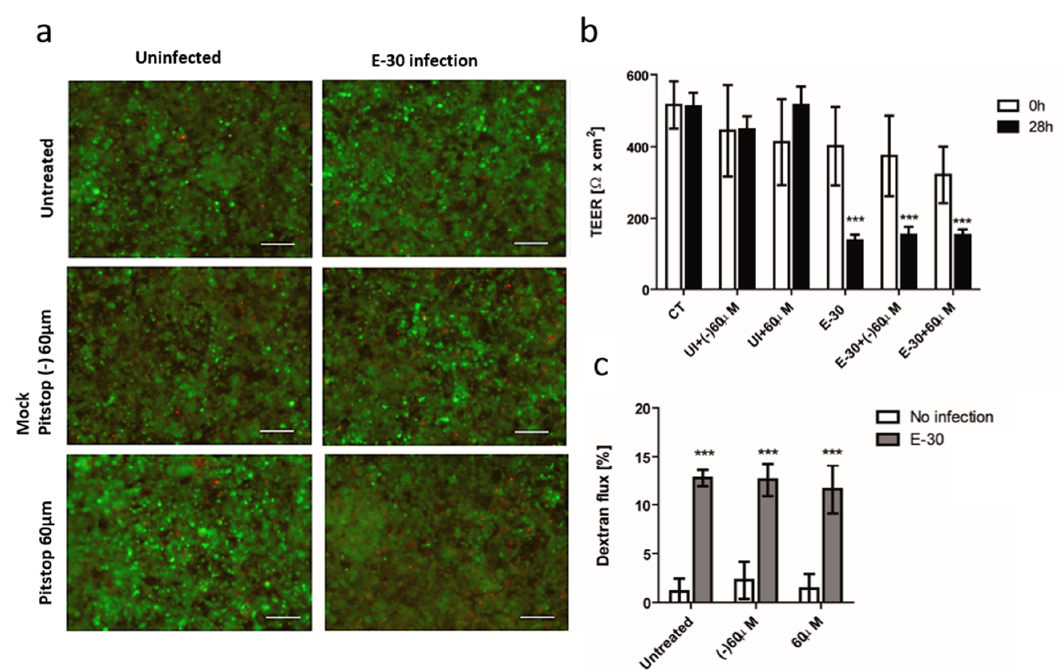
Figure 8. Blocking of dynamin-mediated endocytosis with Pitstop-2 has no impact on the loss of barrier properties of HIBCPP cells following E-30 infection. ( a ) Pitstop-2 and E-30 infection have no drastic impact on HIBCPP cells viability. Live/dead assay stains living cells in green and dead cells in red. Pictures show representative images from 3 independent experiments, each performed in duplicates, for the following conditions (uninfected untreated (CT), uninfected negative control of Pitstop-2 at 60 μM condition ((−)60 μM), uninfected Pitstop-2 at 60 μM condition (60 μM), E-30 infection and no blocking (E-30), negative control of Pitstop-2 at 60 μM + E-30 infection (E-30 + (−) 60 μM), Pitstop-2 at 60 μM in + E-30 infection (E-30 + 60 μM). ( b ) TEER decrease after E-30 infection in presence or absence of Pitstop-2. TEER was measured at T = 0 h (white bars) and T = 28 h (black bars) of the blocking with Pitstop-2, for all the conditions. ( c ) Increased dextran flux following E-30 infection in presence or absence of Pitstop-2. Quantification via fluorescent measurement of paracellular flux with dextran-TexasRed (MW 1000 Da), from T = 24 h to T = 28 h of blocking with Pitstop-2, for all the conditions. Statistical significance was calculated using Student’s t -test. p values are displayed as follows: *** p < 0.001. White scale bars represent 100 μM.